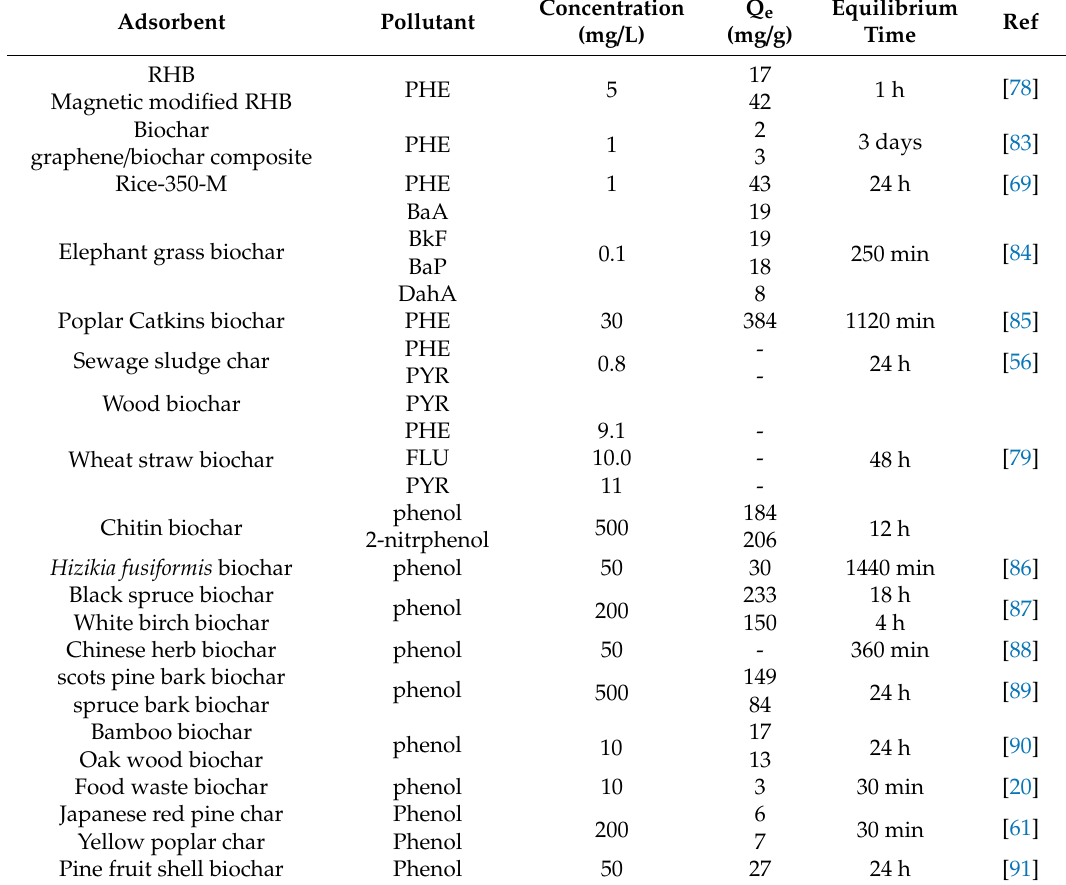
Table 4. Adsorptions of PAHs and phenols using